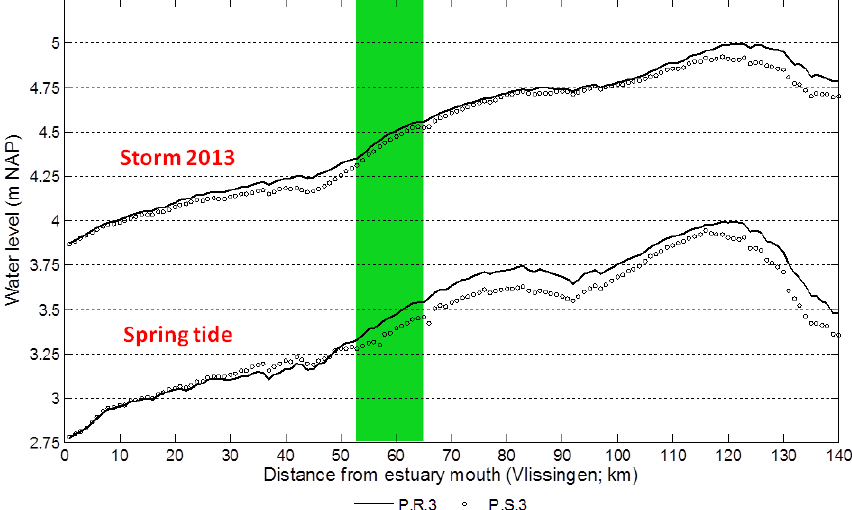
Figure 3. Peak water levels ( y axis) as a function of distance along the estuary ( x axis) during propagation of a spring tide and storm tide (2013) for the realistic (P.R.3) and schematic (P.S.3) reference scenario; the latter with equivalent platform elevation and surface area. The green band in the figure shows the location of the Saeftinghe wetland.